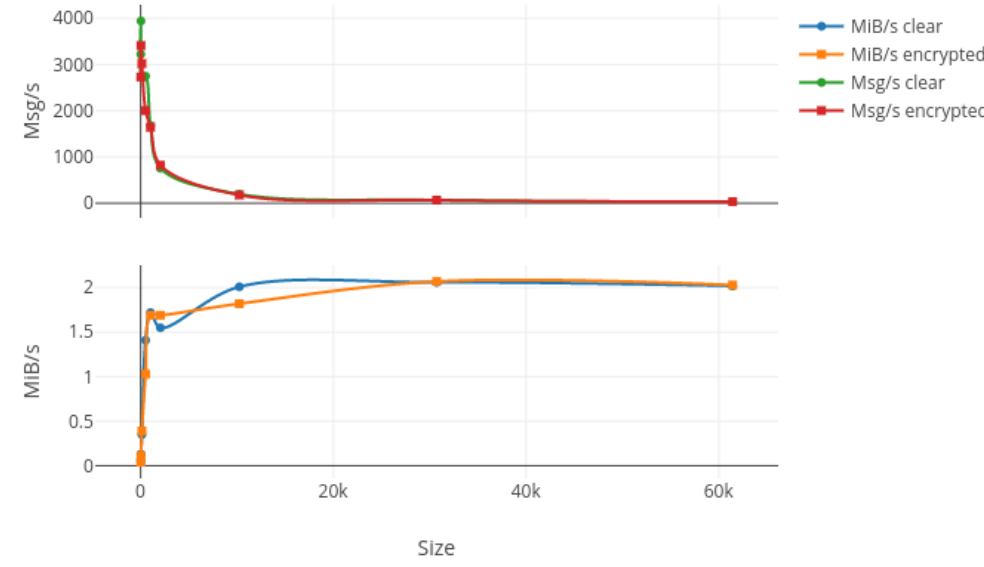
Figure 9. Bandwidth results in terms of Msg/s and MiB/s for 10,000 packets sent on the Raspberry Pi Zero W hardware with increasing message size in both encrypted and clear modes.